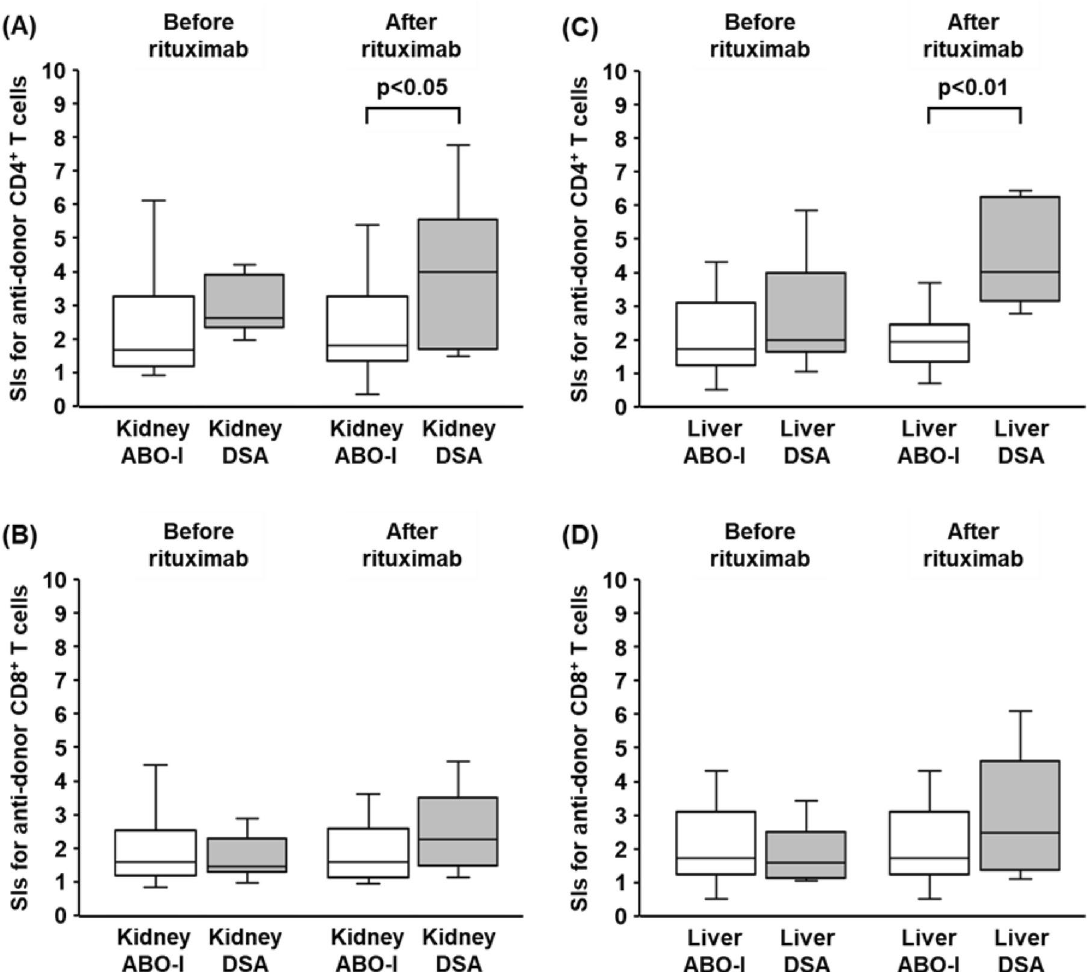
Figure 1. T cell immune responses before and after rituximab administration in desensitized patients. Sixty- two patients received pretransplant desensitization with rituximab. Of these, 17 patients were DSA-positive (kidney, n = 11; liver, n = 6) and the remaining 45 were DSA-negative ABO-I patients (kidney, n = 32; liver, n = 13). To evaluate the T cell immune status of recipients, CFSE-MLR assays were performed before rituximab administration and 2 weeks after rituximab administration (before transplantation). The stimulation index (SI) values of each CD4 + T cells ( A , C ) and CD8 + T cells ( B , D ) before and after rituximab are shown. White box, ABO-I group; gray box, DSA-positive group. Data are shown as median, 25th and 75th percentiles, and range. The Wilcoxon-Mann–Whitney test was used to evaluate differences between before and after